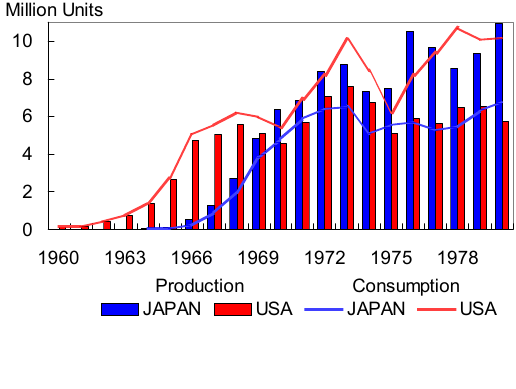
Figure1. Color TV Industry in U.S. and